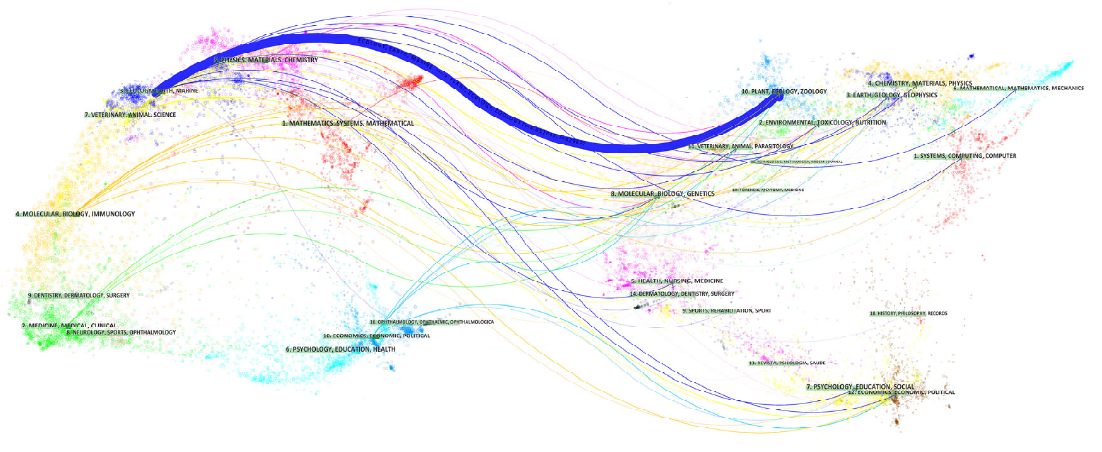
Figure 3. The dual ‐ map overlay. Figure 3. The dual-map overlay. Table 3. The key citation trends. Table 3. The key citation Citing Region